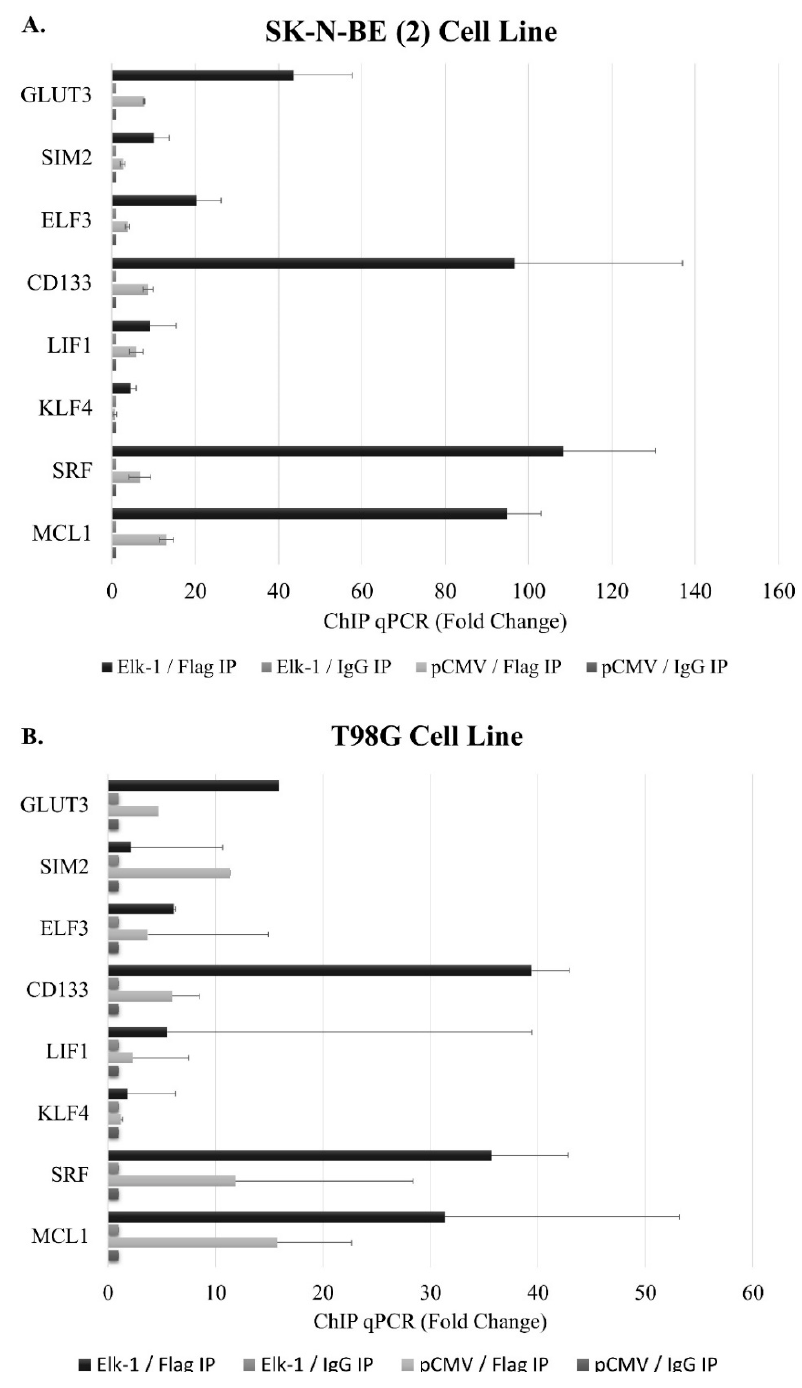
Figure 3. Chromatin immunoprecipitation assay for the identification of Elk-1 binding sites on the target gene promoters in pCMV-transfected (pCMV) vs. Elk-1 over-expressing cells (Elk-1) in ( A ). SK-N-BE (2) cells and ( B ). T98G cells. Lysates were immunoprecipitated with either Flag antibody (Flag IP) for exogenous Elk-1 or IgG (IgG IP) as control. qPCR results were analyzed as explained in Materials and Methods and reported as average fold change.